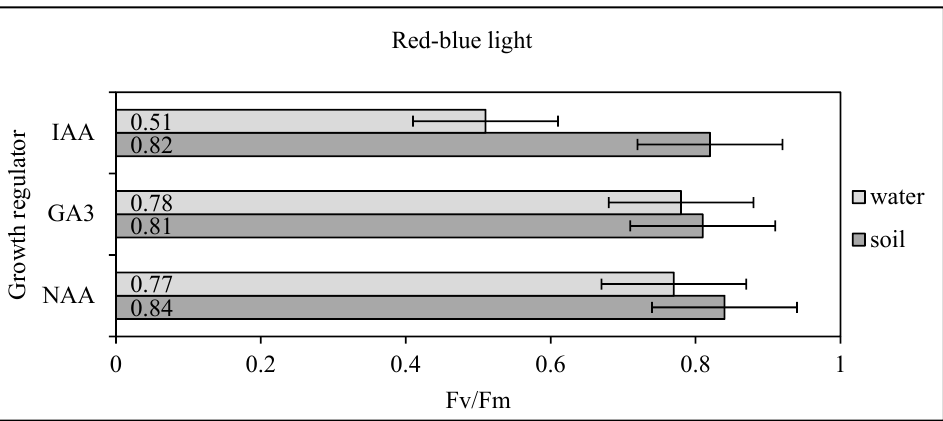
Figure 3. Efficiency of photosystem II photochemistry (Fv/Fm) for seedlings germinated in red-blue light. Vertical bars indicate the standard deviation. IAA—indole-3-acetic acid, GA 3 —gibberellic acid, NAA—1-naphthaleneacetic acid.